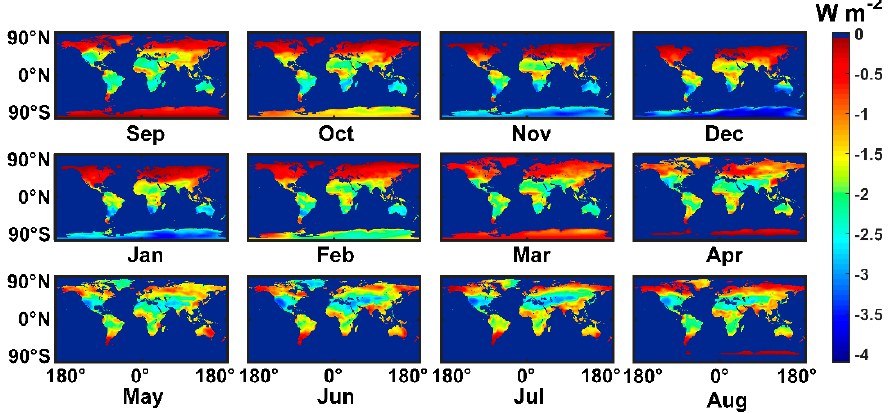
Figure 1. Spatial distribution of monthly surface albedo radiative kernel under all sky (2.8° on average resampled to 0.25° cell size) (these data are based on NCAR’s monthly surface albedo radiative kernel [47]).